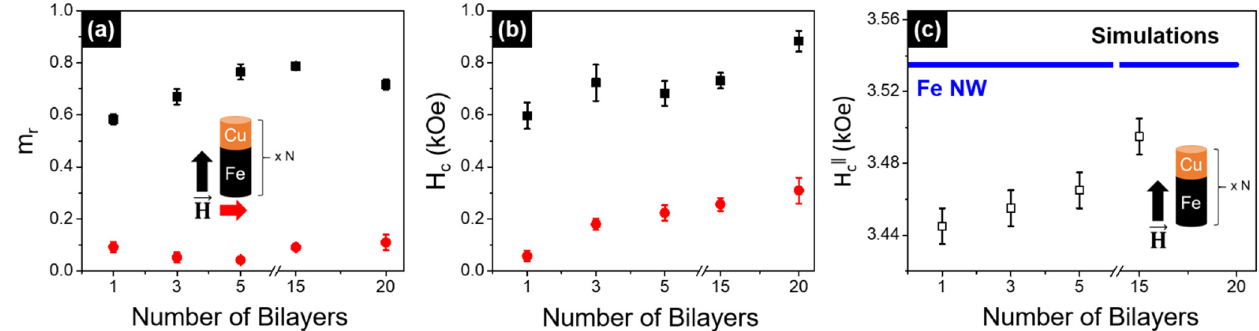
Figure 4. ( a ) Normalized remanence ( m r ) and ( b ) coercivity ( H c ) values as a function of the number of Fe/Cu bilayers, measured when applying a magnetic field parallel (black squares) and perpendicular (red dots) to the wire’s axis. ( c ) Coercive field of the segmented Fe/Cu NWs, as a function of the number of layers (open symbols), and of the 3 µm length isolated Fe NW (blue continuous line) extracted from the simulated hysteresis loops when the external field was applied parallel to the NW axis.